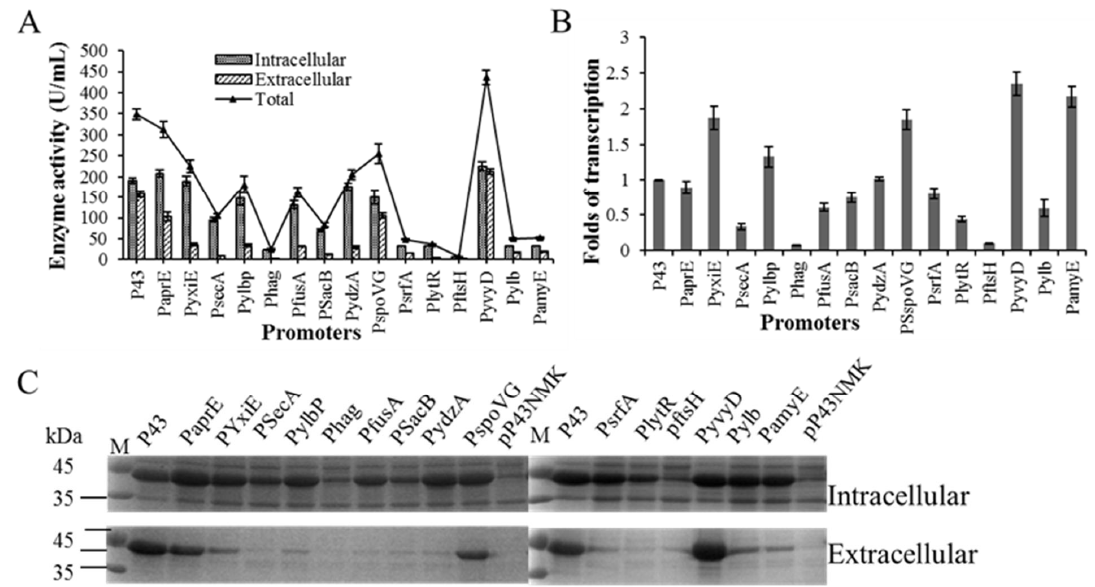
Figure 3. BlAase transcription and translation levels mediated by distinct single promoters: ( A ) BlAase expression levels with different single promoter engines; ( B ) BlAase transcription levels with different single promoter engines; ( C ) BlAase SDS–PAGE analysis with different single promoter engines.